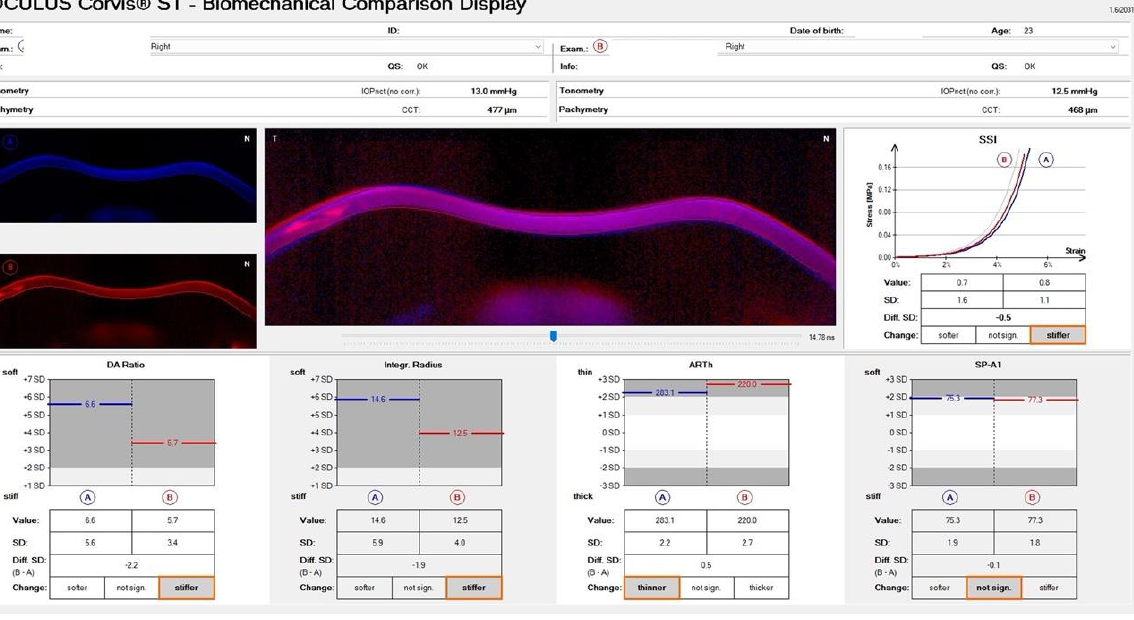
Figure 7. Biomechanical Comparison Display showing a stiffer cornea after the ICRS implantation.